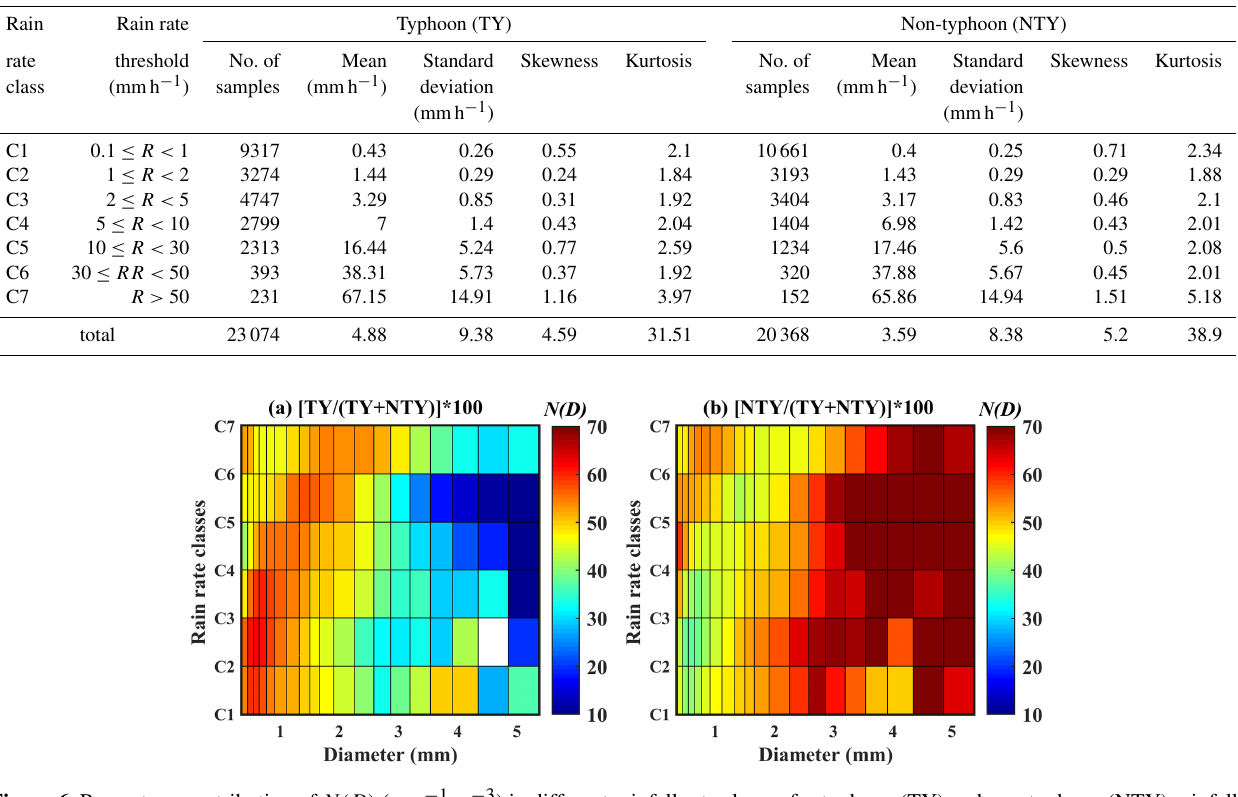
Figure 6. Percentage contribution of N(D) (mm − 1 m − 3 ) in different rainfall rate classes for typhoon (TY) and non-typhoon (NTY) rainfall.